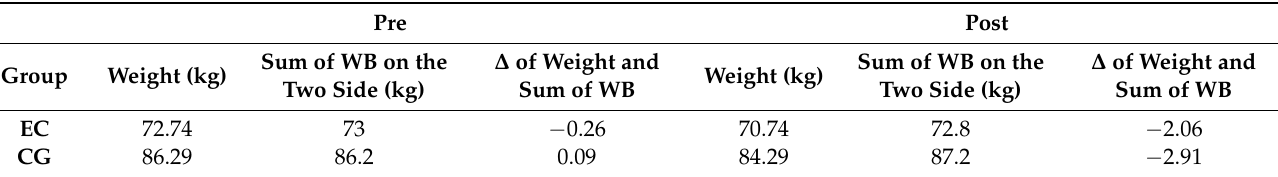
Table 4. Weight and WB sum in the